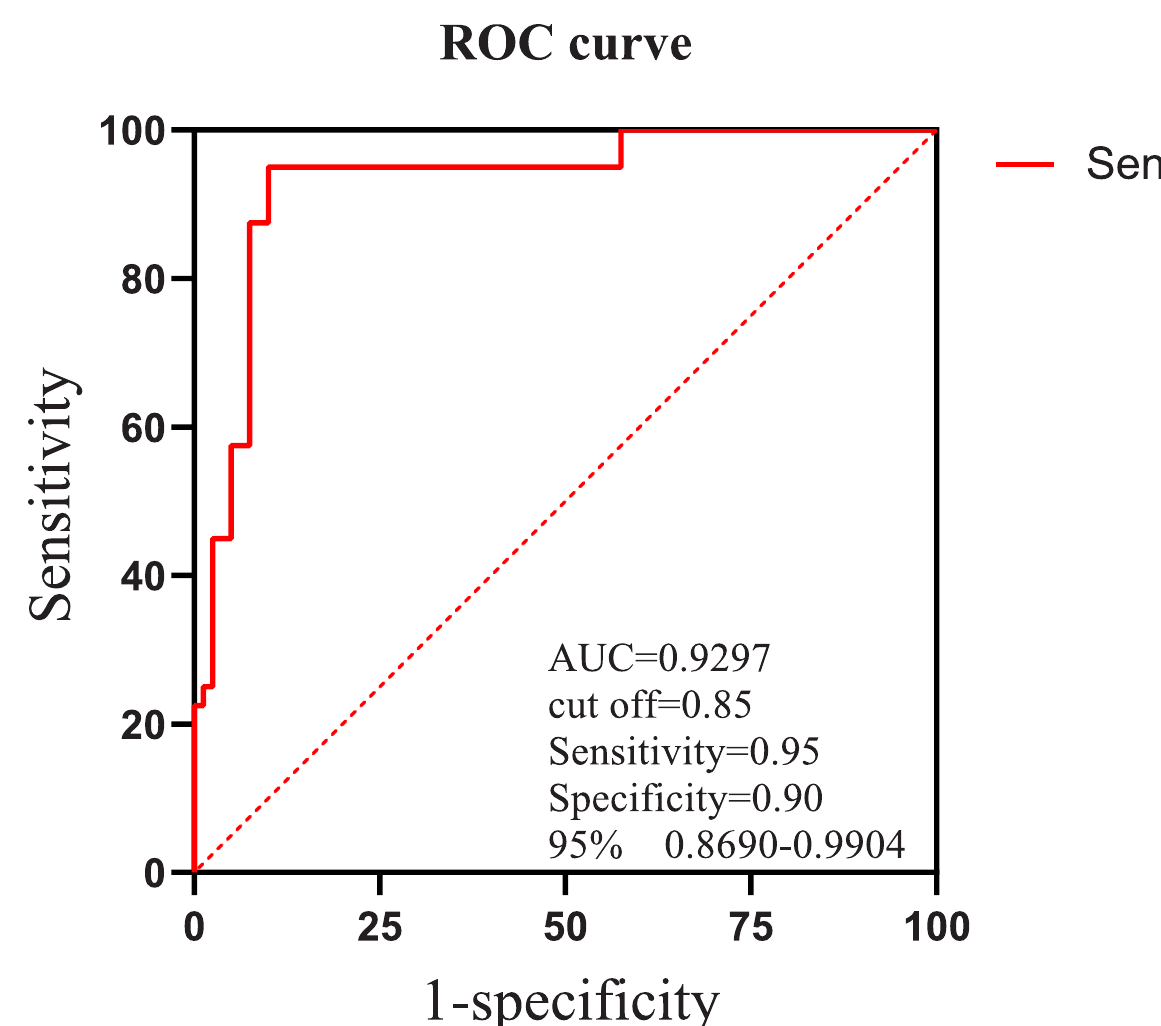
Fig 3. Receiver operating characteristic (ROC) curve. The abscissa indicates the sensitivity, while the ordinate indicates 1-specificity. At a cut-off of 0.85, the area under the curve (AUC) peaked, while the sensitivity and specificity of the best cut-off point were 0.95 and 0.90, respectively. At this time, the hsa_circ_0004099 level was the highest predictive value for AIS